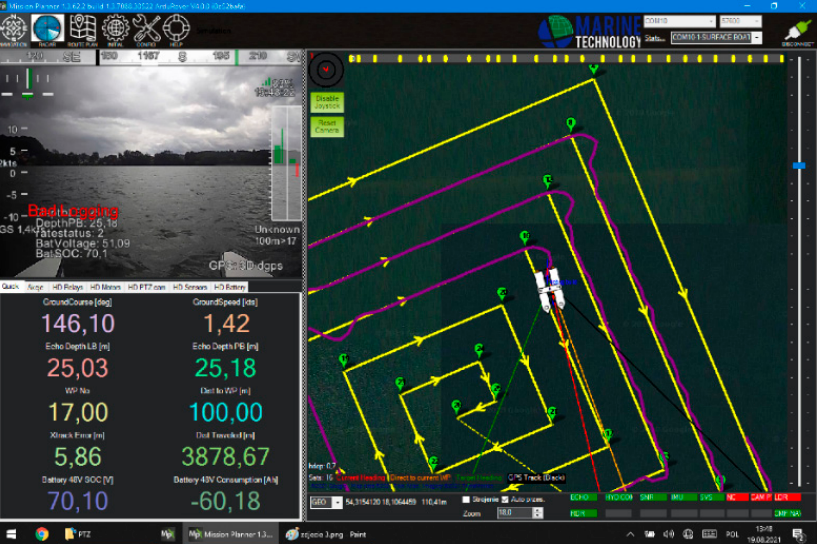
Figure 6. Window of the ArduPilot Mission Planner application used for the planning and recording of a vessel’s route.